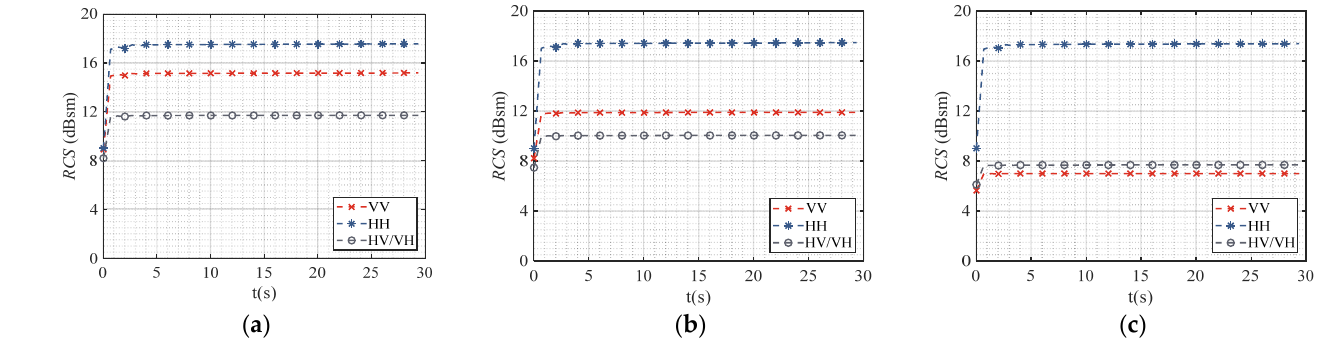
Figure 11. Monostatic polarization RCS for a dynamic chaff cloud. ( a ) θ = 30 ◦ , ϕ = 0 ◦ ; ( b ) θ = 45 ◦ , ϕ = 0 ◦ ; ( c ) θ = 60 ◦ , ϕ = 0 ◦ . The signal attenuation by the chaff cloud is shown in Figure 12 for various incident wave frequencies. The simulation parameters are as follows: atmospheric wind speed = (5, 5, 0) m/s, resolution cell = 1 × 1 m 2 , θ i = 30 ◦ and ϕ i = 0 ◦ . The horizontal coordinates are the serial numbers of the resolution cells along with the longitudinal extension in the direction of the incident plane, and the vertical coordinates are the signal power after the chaff cloud has attenuated it. The attenuation of the spread ‐ out chaff cloud for the incident wave at 5 GHz, with chaff elements of 1,000,000, 500,000, and 1,000,000, respectively, are presented in Figure 12a–c. The incident wave at 10 GHz is given in Figure 12d–f, with chaff elements of the 1,000,000, 500,000, and 1,000,000, respectively. The graph shows that when the total number of chaffs rises, the number of cells with severe attenuation in ‐ creases, and the maximum attenuation increases at the same time. To obtain the same amount of interference for higher frequency radar signals, additional chaffs are necessary.